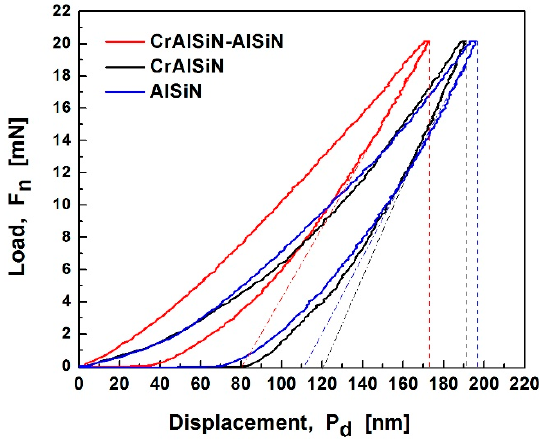
Figure 3. Typical loading–unloading curves of CrAlSiN–AlSiN, CrAlSiN, and AlSiN coatings.